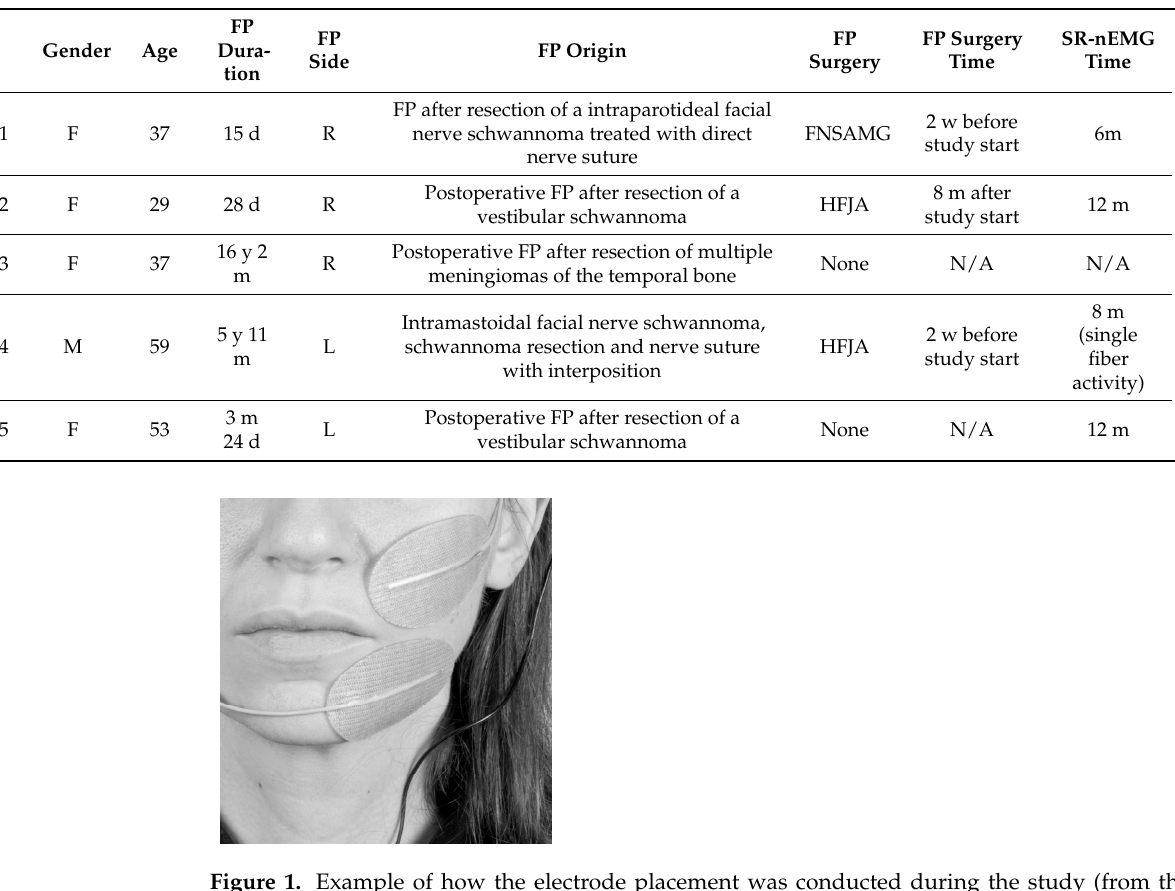
4 of 14 Table 1. Patients’ demographic data and facial paralysis history. FP = facial paralysis; F = female; M = male; SR-nEMG time